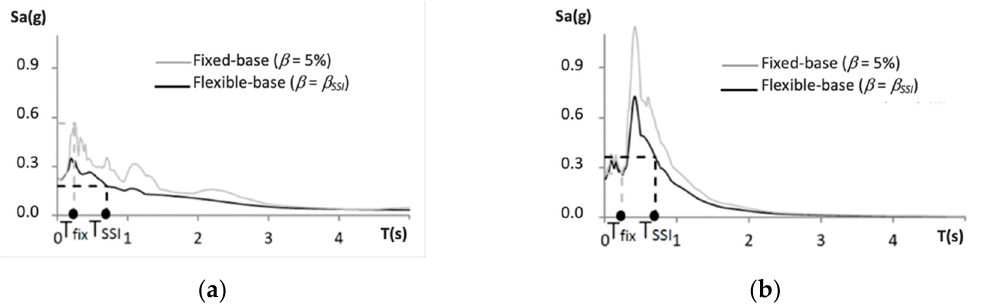
Figure 1. A schematic explanation of the period elongation effect due to the soil-structure interaction (SSI) on the seismic force imposed on a structure depending on the seismic input and soil conditions: ( a ) beneficial effect of SSI reflected in S a ( T SSI )/ S a ( T fixed ) ratio below unity; ( b ) detrimental effect of SSI reflected in S a ( T SSI )/ S a ( T fixed ) ratio above unity.